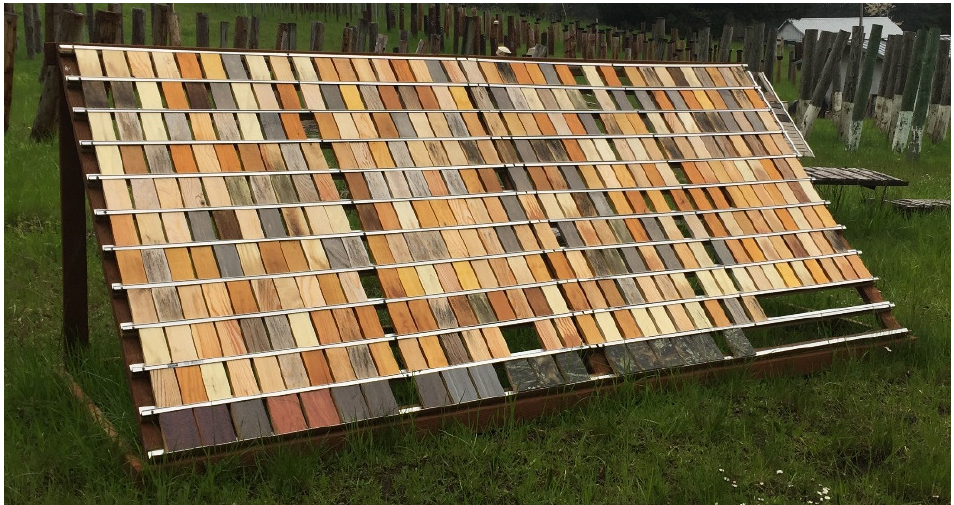
Figure 1. Coated samples exposed to natural weathering at a 45° angle on a test fence near Corvallis, OR. The same setup was used in both the Corvallis and Madras locations.